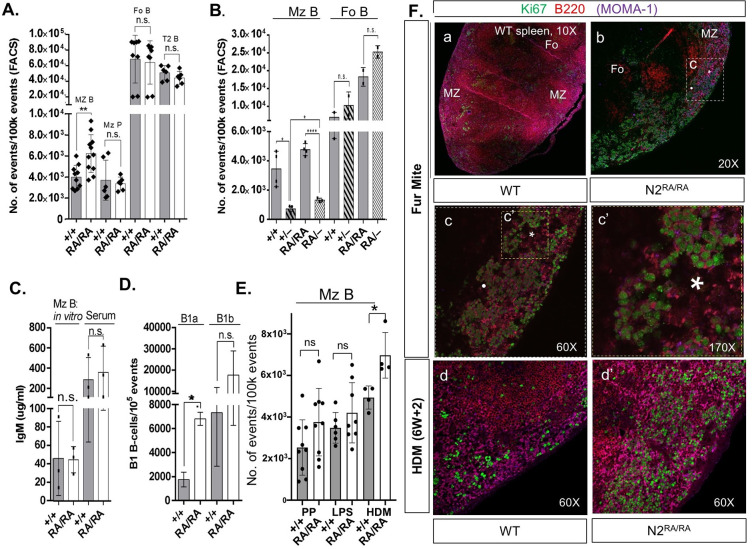
Loss of Notch2 dimerization expands the splenic MZB compartment in the presence of mites.A. FACS analysis of N2RA/RA fur mite–infested mouse spleens revealed an expansion the MZB compartment relative to WT (+/+). Values for MZP, F0, and T2 splenic B-cell populations were not significantly different; n = 11. B. The MZB cell compartment in heterozygotes. C. LPS-induced differentiation and IgM production in vitro and serum levels of IgM in vivo; n = 4. D. Peritoneal B1a B-cell compartment in mite-infested WT and N2RA/RA mice (n = 2). E. The MZB cell compartment in N2RA/RA mice after treatment with permethrin, an immunosuppressant used to manage fur mite infestation (PP), after LPS, or after 6 weeks of treatment with HDM extract. (*p < 0.05). Note, although a slight trend is seen in mite-free animals, power analysis indicates it would take 212 mice displaying this trend to reach significance. For LPS-treated mice, it would take 41 animals displaying this trend to reach significance. Only 4 mice were sufficient to reach significance after treatment with HDM. In (A-E) p-values generated by 2-tailed t-test. Error bars represent SD. F. Proliferation in the splenic marginal zone of mite-infested mice: (Fa) The spleen from a mite-infested control animal or (Fb) from N2RA/RA mice. Boxed region magnified in Fc and again, in Fc’, asterisk and dot provided for orientation. Magnification noted. (Fd, d’) 60× view of marginal zone from control and HDM-treated N2RA/RA mice. Raw data in S1 Data. F0, Filial generation 0; FACS, fluorescence-activated cell sorting; FoB, follicular B-cell; HDM, house dust mite; IgM, immunoglobulin M; LPS, lipopolysaccharide; MZB, marginal zone B-cell; N2RA/RA, Notch 2 Arg1934Ala homozygous; ns, not significant; P, postnatal day; PP, post-permethrin; T2, type 2 cell; WT, wild-type.